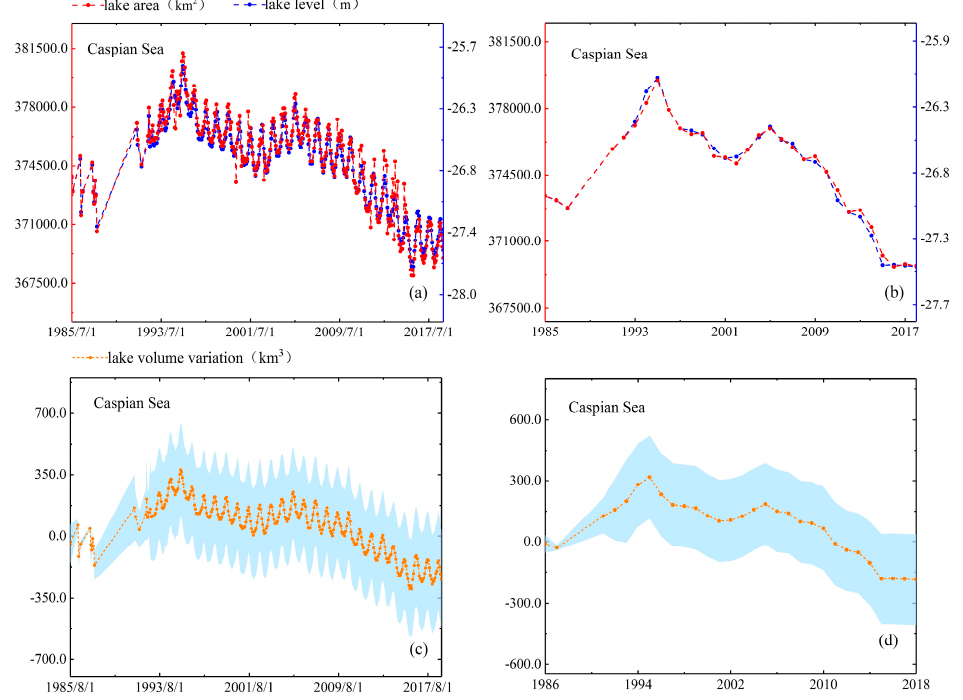
Figure 5. Lake area, level and volume variations in monthly ( a , c ) and annual ( b , d ) timescales for Caspian Sea. Caspian